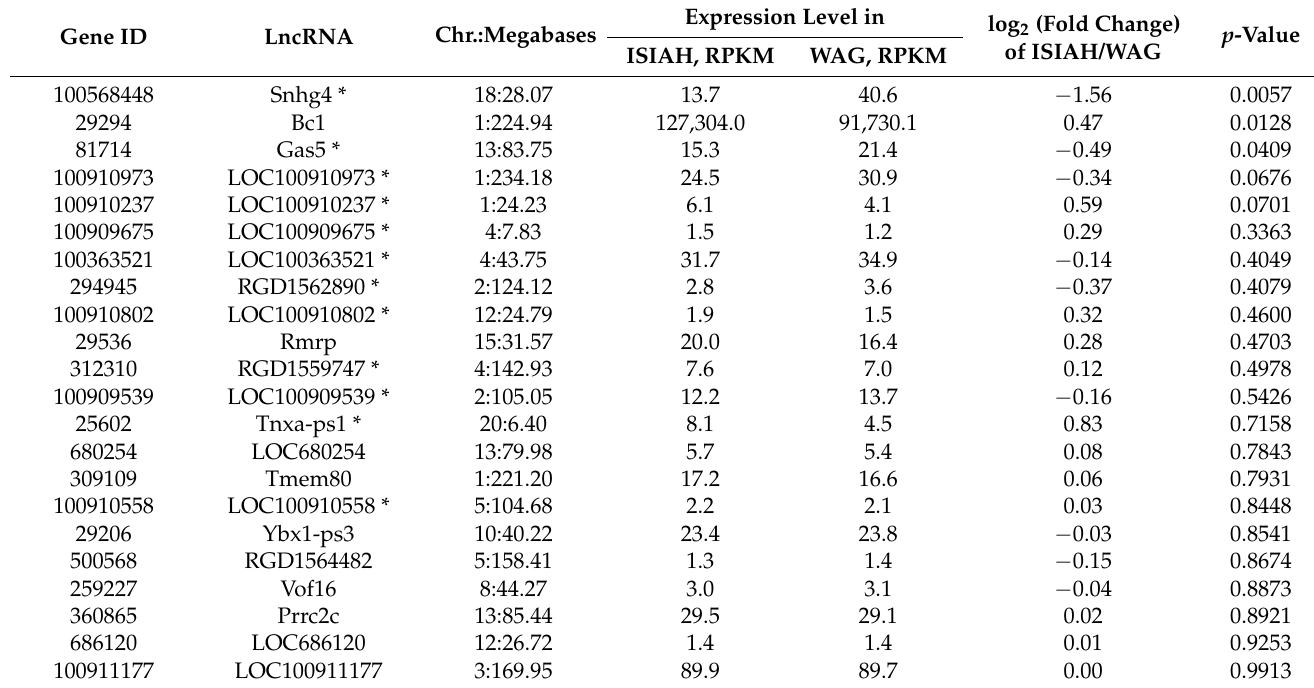
Table 1. The expression level of lncRNAs detected in the hypothalamus of ISIAH and WAG rats (RNA-Seq